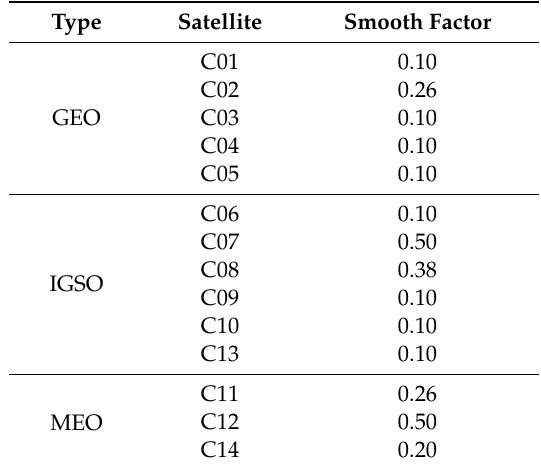
Figure 7. Clock differences between true (GFZ precise clock products) and prediction, using Figure 7. Clock di ff erences between true (GFZ precise clock products) and prediction, using di ff erent different smooth factors. smooth factors. Table 2. Recommended smooth factor for each BDS-2 Table 2. Recommended smooth factor for each BDS-2 satellite.